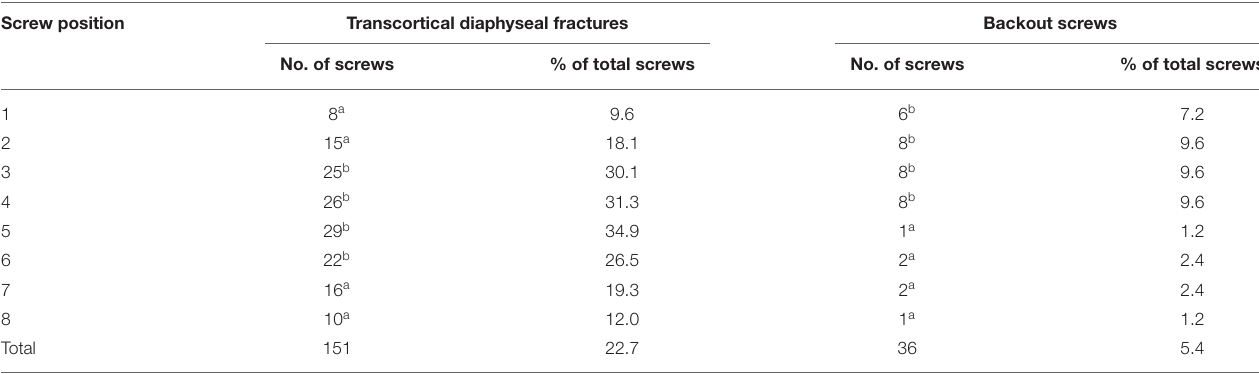
TABLE 2 | Transcortical diaphyseal tibial fractures and backout screws